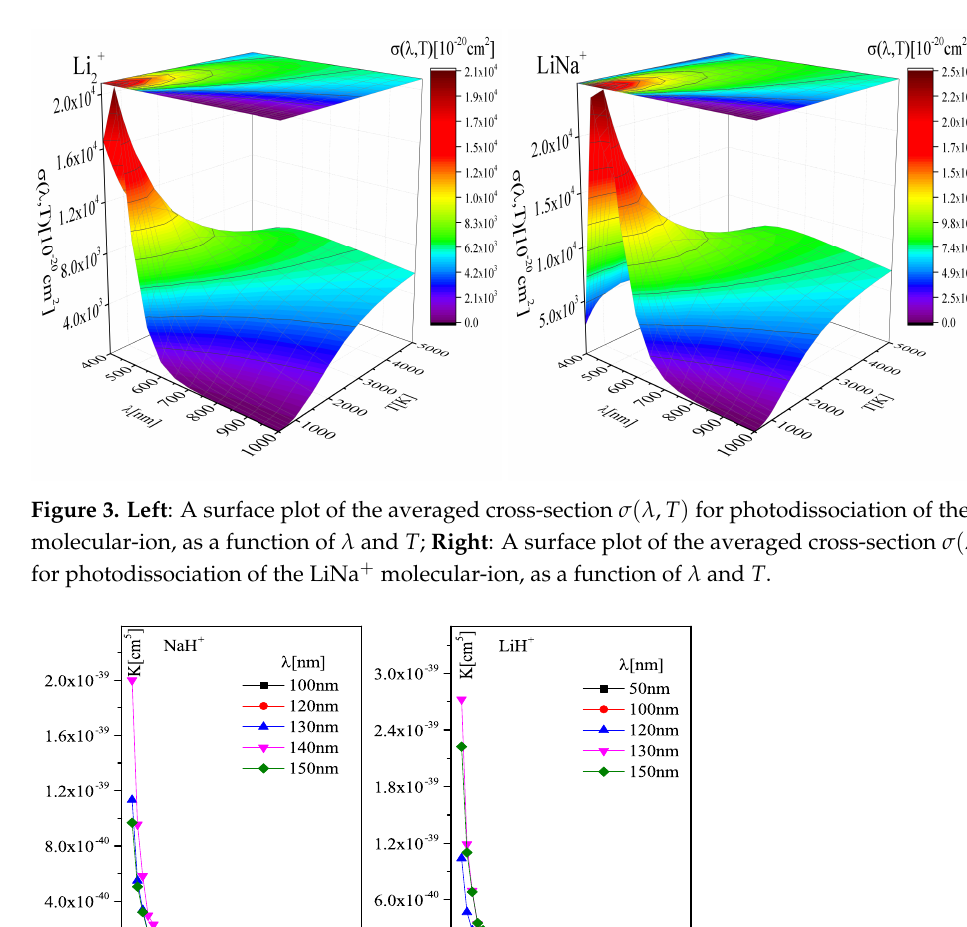
Figure 4. The plot of the spectral rate coefficients K ( λ , T ) for photodissociation of the NaH + , LiH + , as a function of T and λ